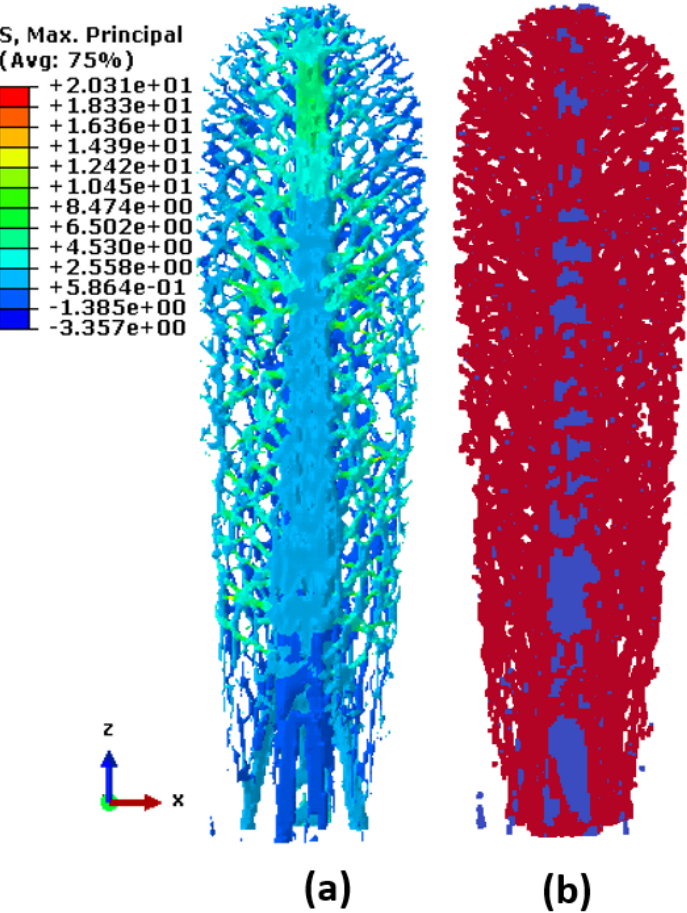
Figure 16. Hard cartilage of paddlefish rostrum. ( a ) Maximum principal stress obtained from finite element analysis. ( b ) Minimum cut obtained from mathematical analysis on bottom surface of rostrum’s hard cartilage. Nodes are colored by their respective locations on the source (red) or sink (blue) side of the minimum cut.